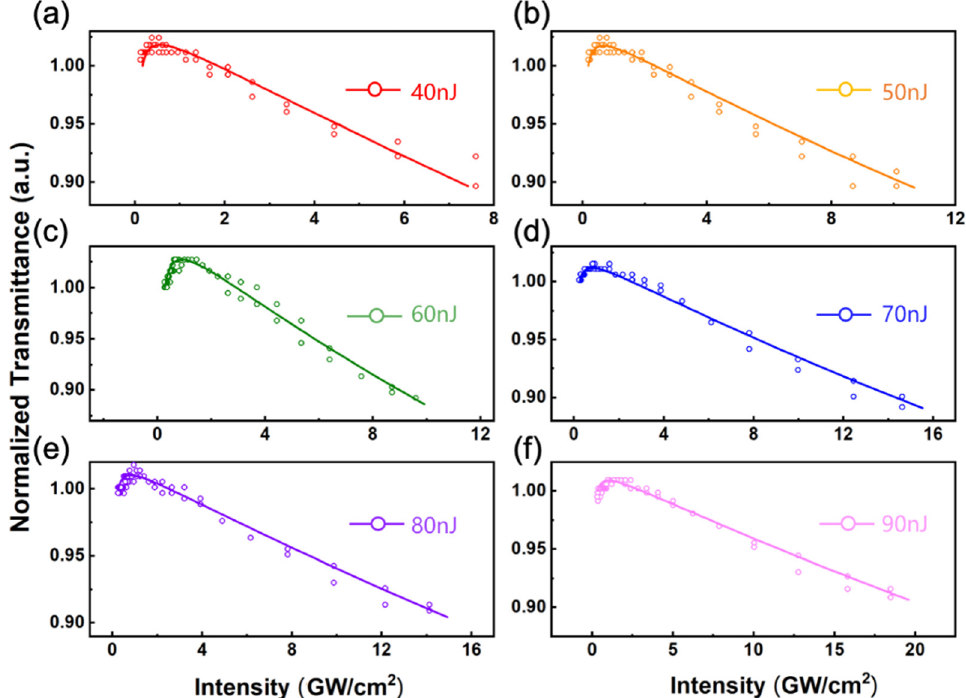
Figure 6. ( a – f ) Normalized transmission as a function of incident laser intensity from 40 to 90 nJ. The scatters are experi- mental data and solid lines are the fitting